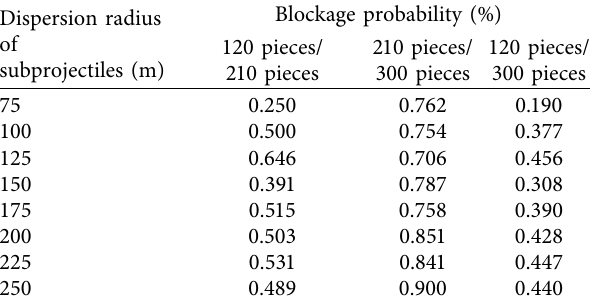
Table 9: Processed